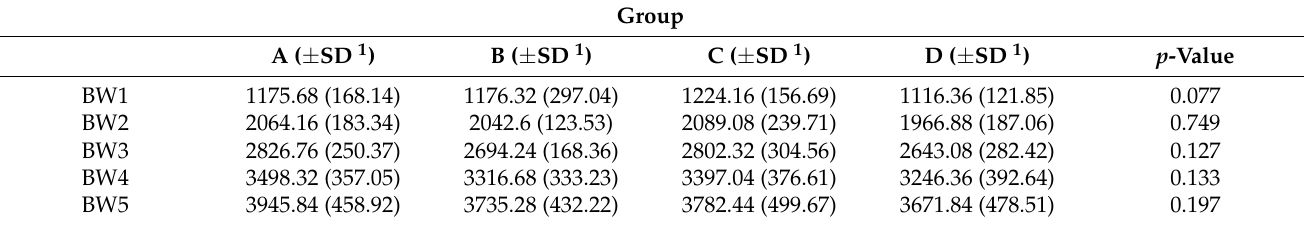
Table 4. Descriptive statistics (mean and standard deviation) for skins of female mink ( n = 6 per group).